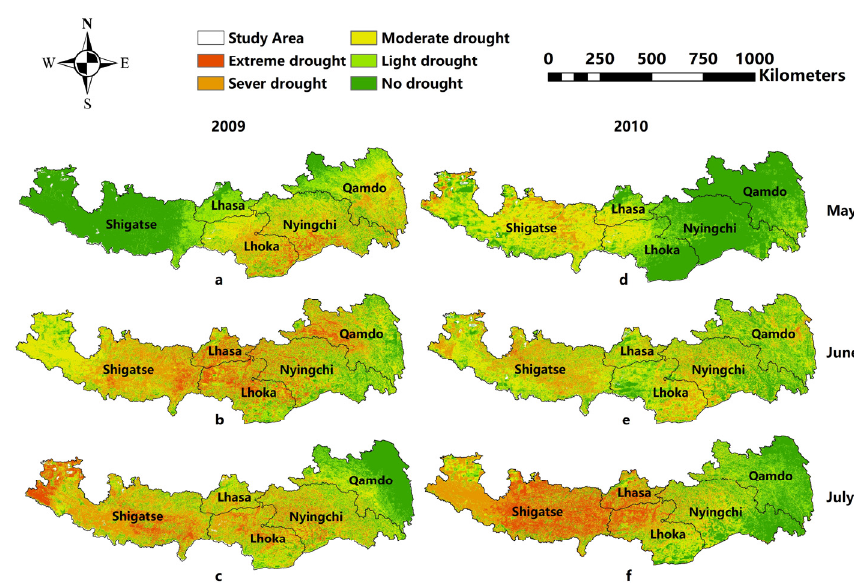
Figure 8. Simulation drought distribution by three models from May to July 2009 and 2010: ( a ) drought simulation in May 2009; ( b ) drought simulation in June 2009; ( c ) drought simulation in July 2009; ( d ) drought simulation in May 2010; ( e ) drought simulation in June 2010; ( f ) drought simulation in July 2009.